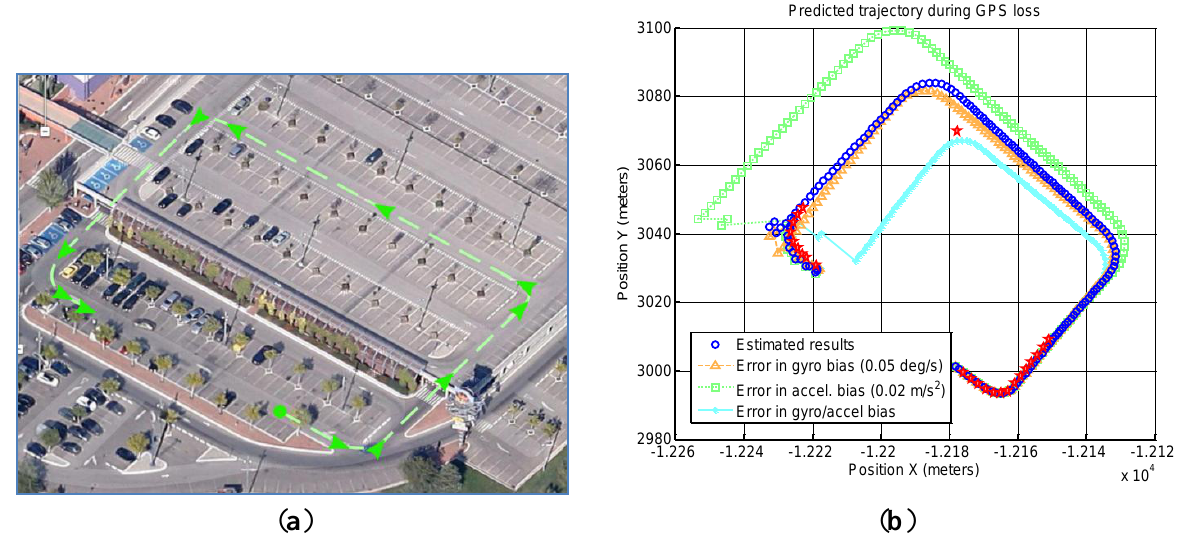
Figure 18. ( a ) Vehicle trajectory ( b ) Predicted